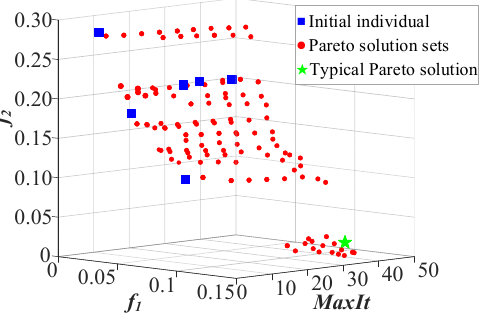
Figure 10. 3D view of the Pareto solution trajectory of the hybrid algorithm.